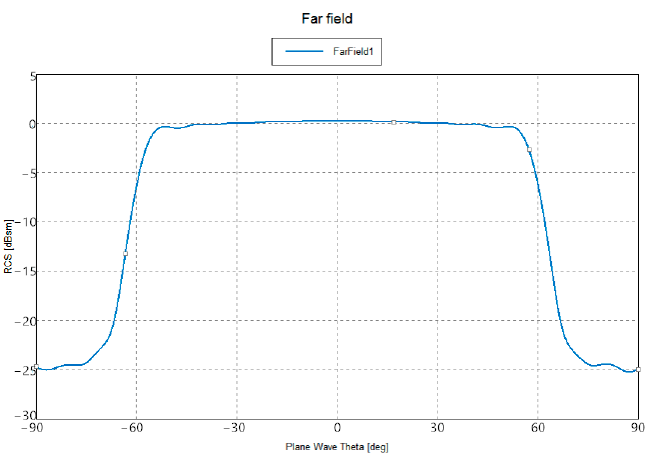
Figure 6. Radar cross-section distribution characteristics of a Luneburg ball.